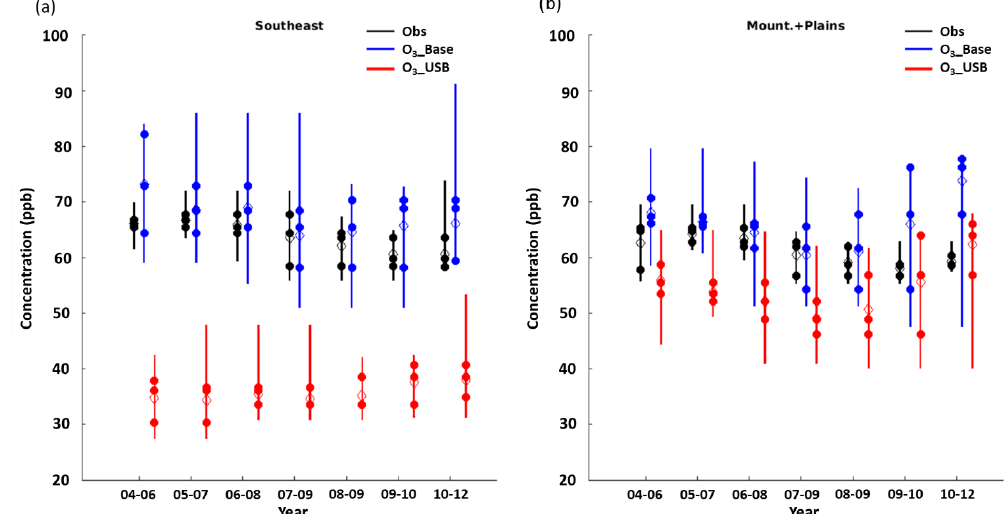
Figure 9. The three fourth highest values (solid dots) used to calculate the 3-year average of the fourth highest MDA8 O 3 day (hollow diamond). Vertical bars show the range between the highest and lowest O 3 _top10obs days across each 3-year span (i.e, across 30 total points) occurring between March and October in the (a) Southeast and (b) Mountains and Plains regions in the observations (black), and the O 3 _Base (blue) and O 3 _USB (red) simulations sampled on the same days as the top 10 observed